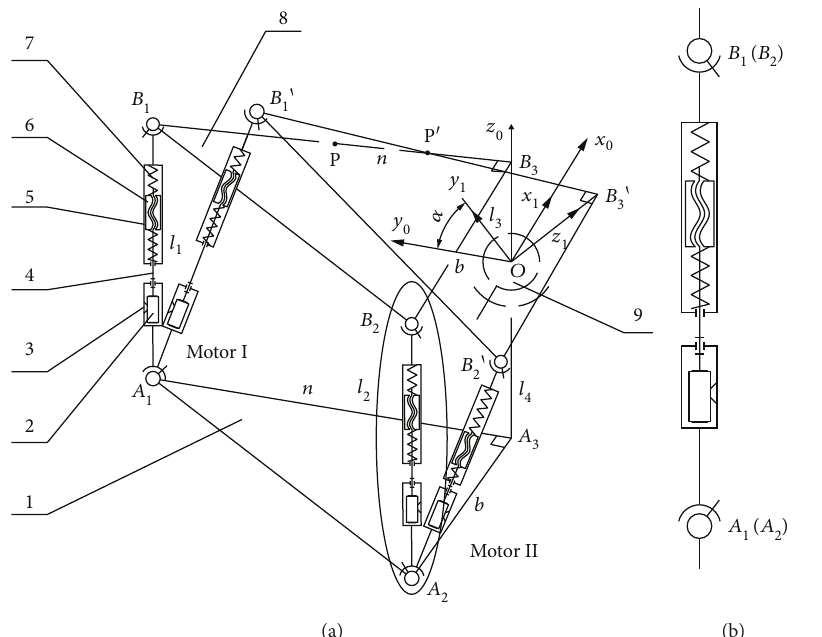
Figure 2: Schematic of the robot. (a) The robot rotates by an angle of α around the X 0 -axis. (b) Drive branch chain. (1) Lower platform, (2) motor, (3) U-shaped connector, (4) screw rod, (5) guide frame, (6) slider block, (7) spring, (8) upper platform, and (9) ball pin